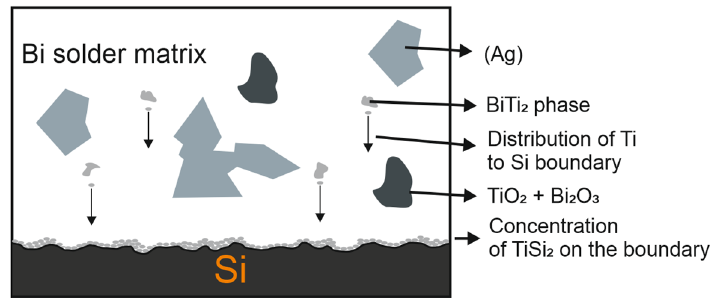
Figure 17. Mechanism of bond formation.